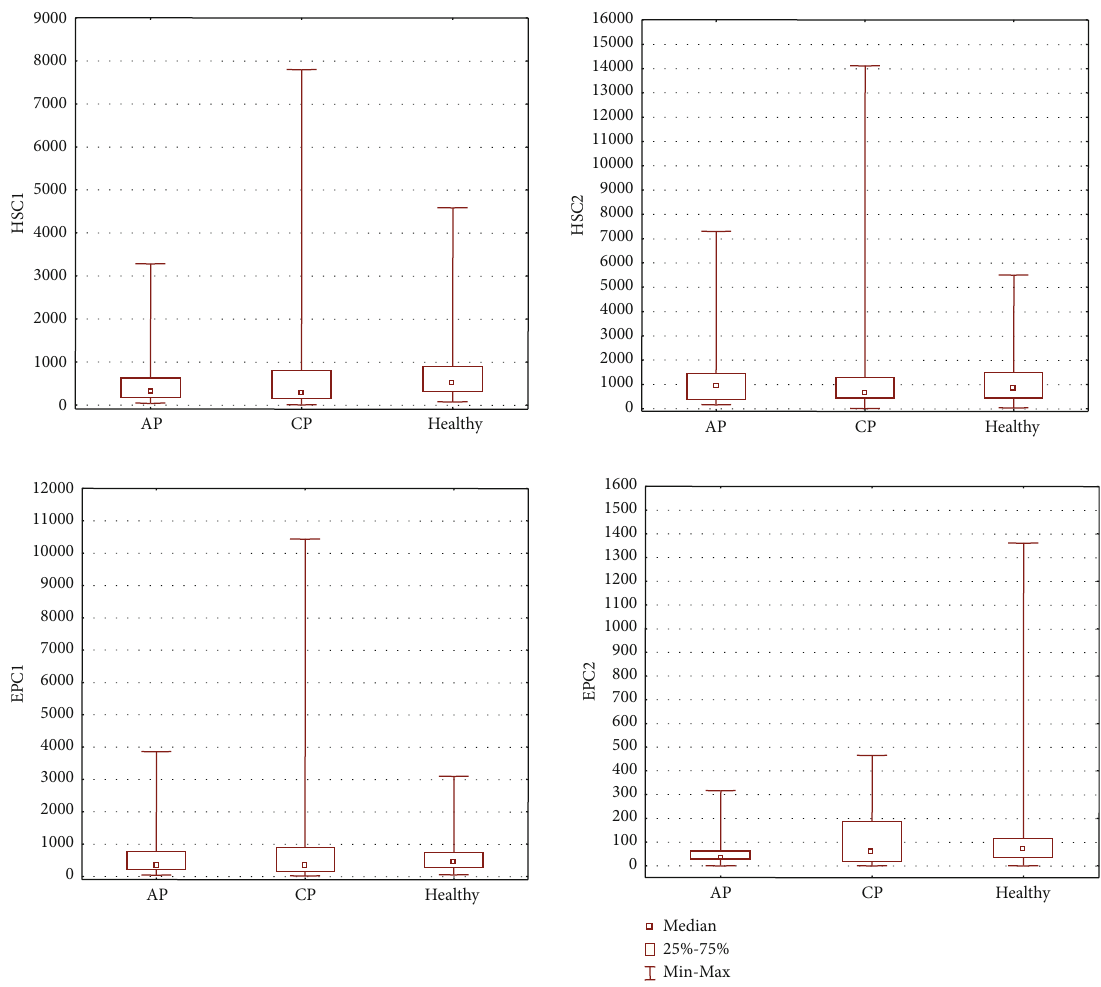
Figure 2: The absolute numbers of the HSCs “ 1 ” , HSCs “ 2 ” , EPCs “ 1 ” , EPCs “ 2 ” subpopulations circulating in the PB of